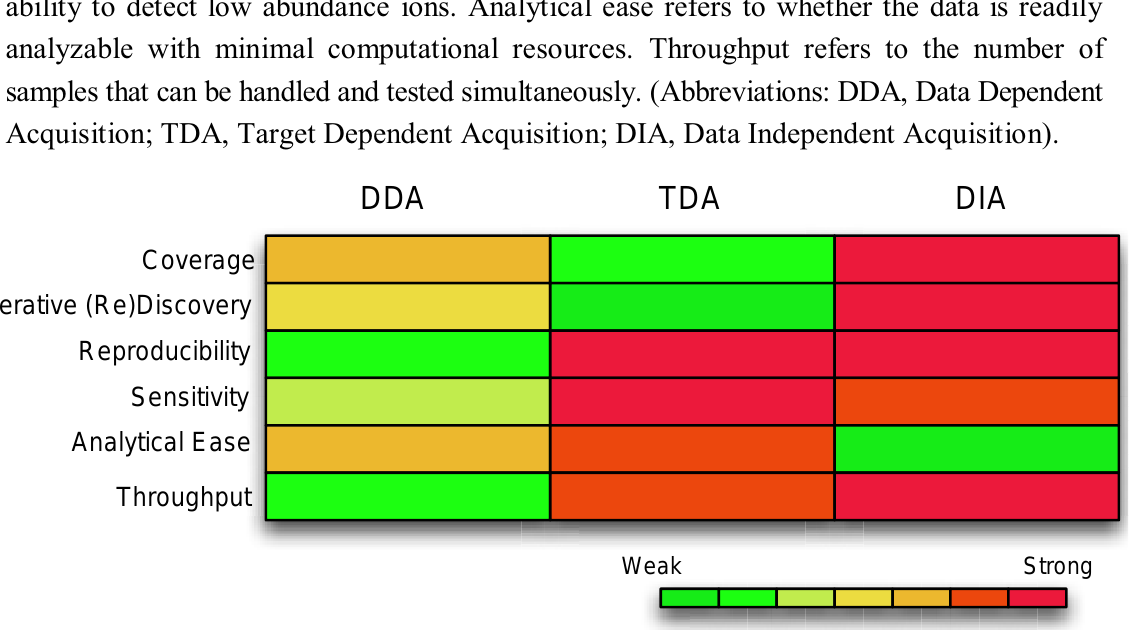
Figure 1. A comparison of the different features compassing each acquisition strategy. The color coding represents the strength of the data acquisition, with warmer colors as strong and cooler colors as weak. Coverage is the extent of the underlying assayable